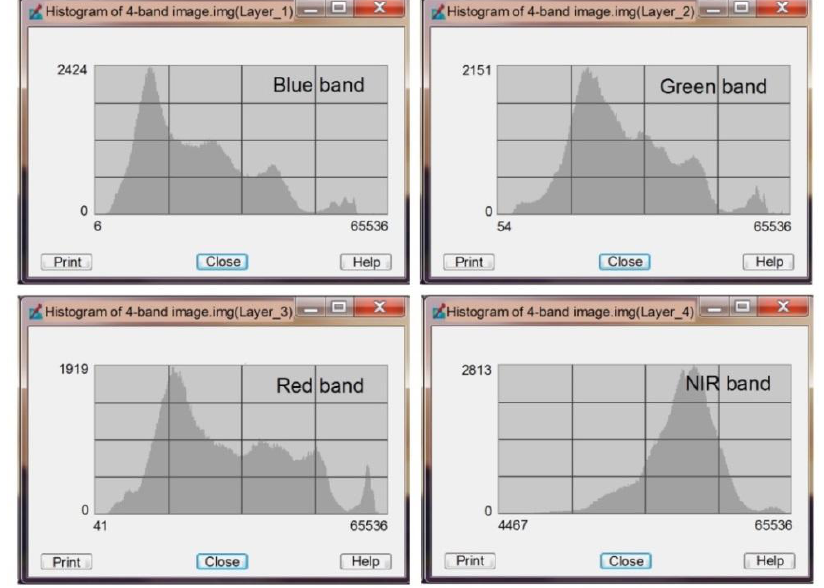
Figure 5. Histograms of the four bands for the images shown in Figure 4.